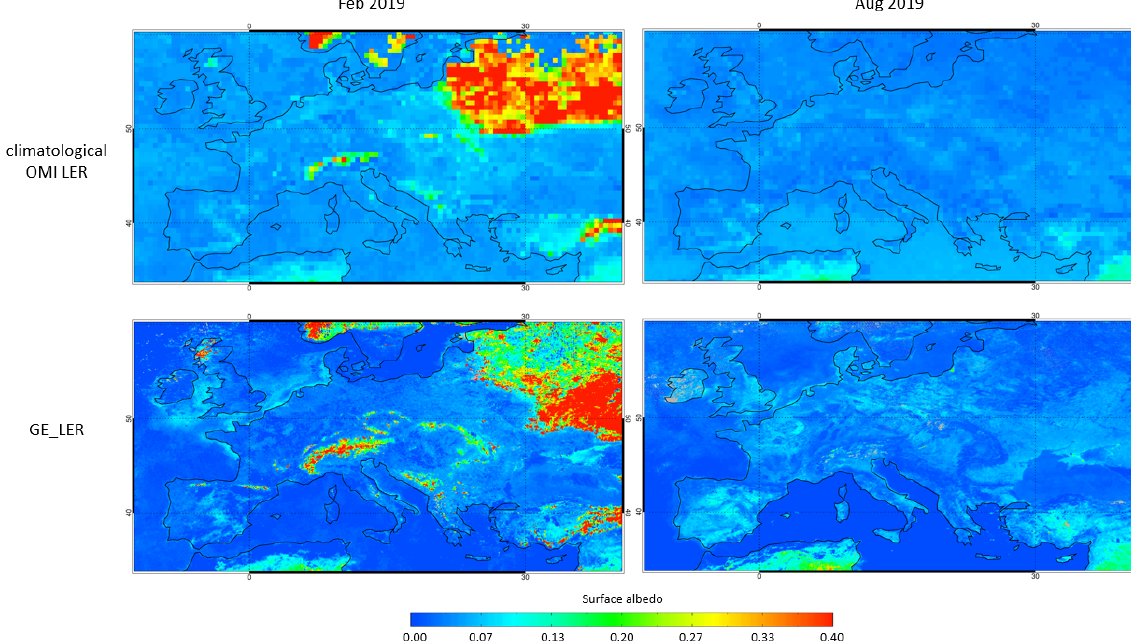
Figure 7. OMI surface LER climatology at 440nm (Kleipool et al., 2008) and GE_LER retrieved from TROPOMI data in the NO 2 retrieval window (405–465nm) over Europe in February and August 2019.